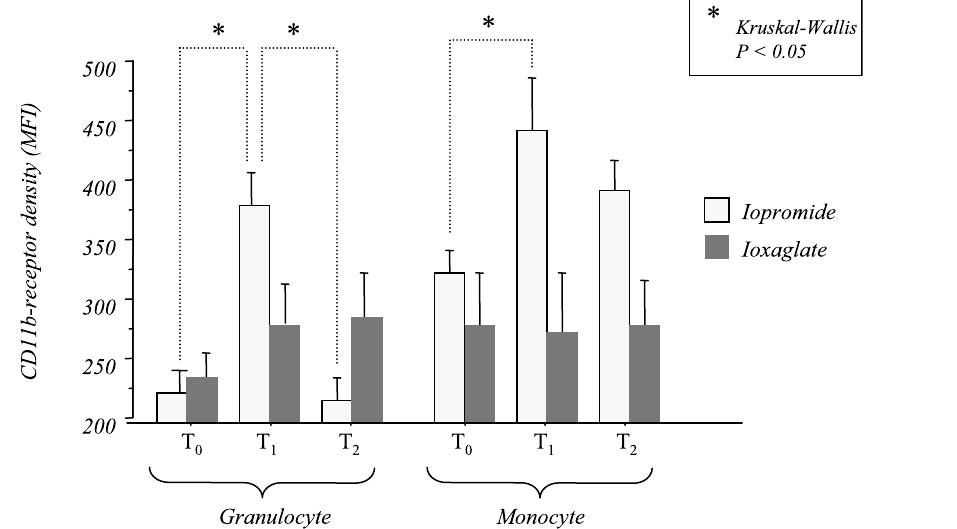
FIG. 1. Changes in CD11b levels on leukocytes after RCM infusion. The mean fluorescence intensity (MFI) of anti-CD11b antibody on granulocytes and monocytes during infusion of iopromide and ioxaglate. T 0 , sample taken before the initiation of